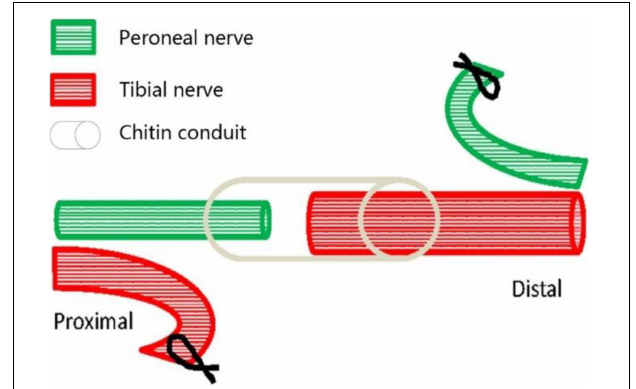
FIGURE 1 | Surgical diagram of collateral peripheral nerve regeneration in group B. The proximal peroneal nerve is used to repair the distal tibial nerve. The peroneal nerve and tibial nerve are cut off, the proximal tibial nerve and distal peroneal nerve are sutured to nearby muscles, and then the distal tibial nerve is repaired by the proximal peroneal nerve through anastomosis with biodegradable chitin